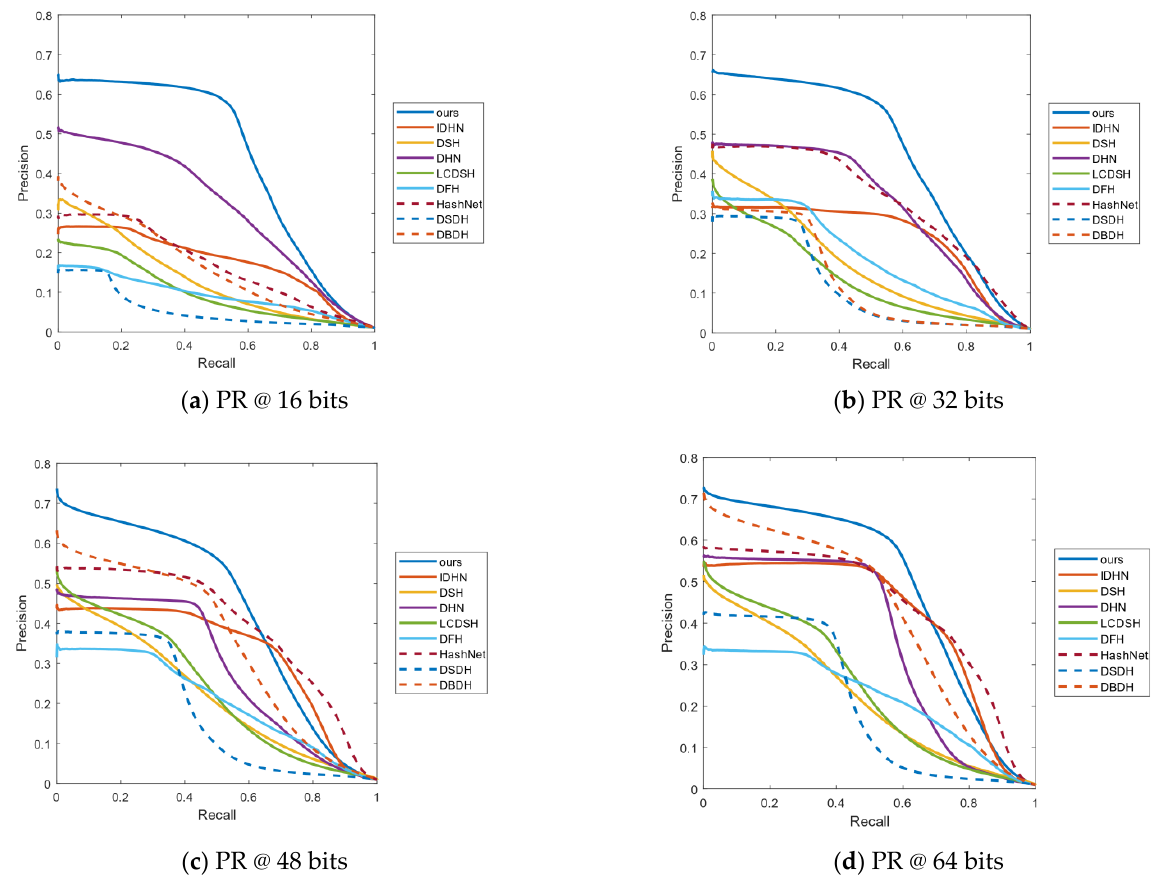
Figure 5. ( a – d ) represent the PR curves on Imagenet-100 of all algorithms when the length of the hash code is 16, 32, 48 and 64 bits,